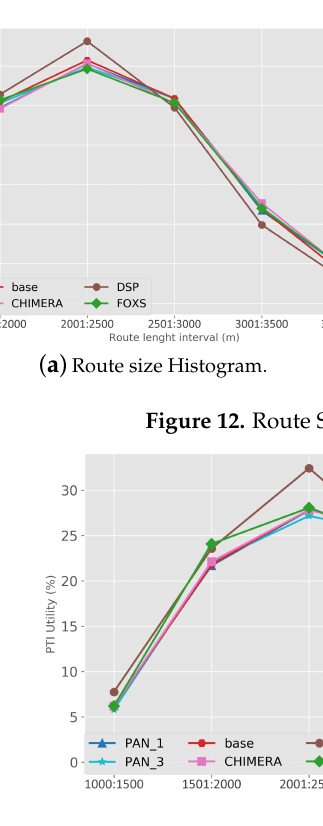
Figure 13. PTI Utility metric—Ottawa